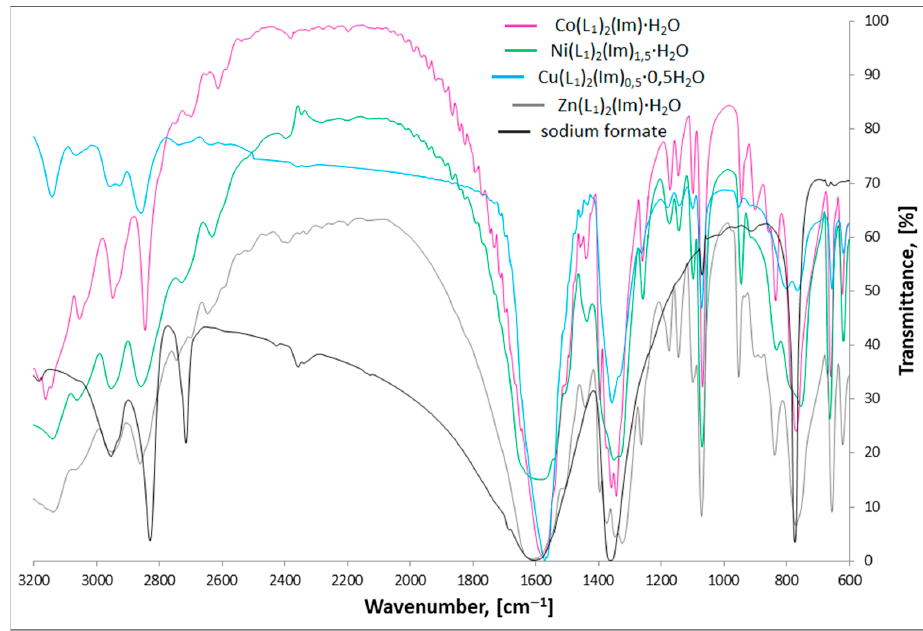
Figure 3. FTIR spectra of studied M(II) formate-imidazole complexes and sodium formate.